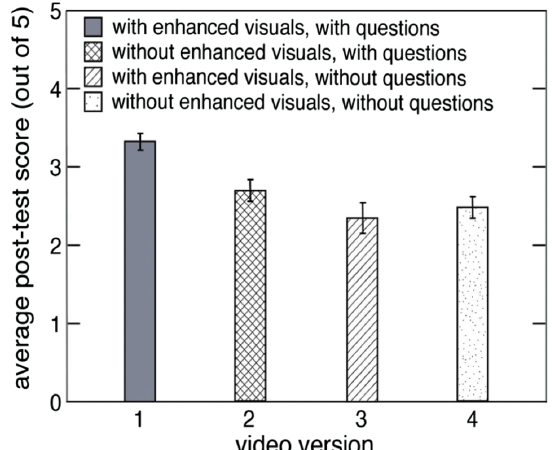
FIG. 9. Average postvideo test score for participants who watched each of the four versions of the videos: version 1: with enhanced visuals and embedded questions; version 2: without enhanced visuals, with embedded questions; version 3: with enhanced visuals, without embedded questions; version 4: with- out enhanced visuals, without embedded questions. Error bars represent the standard error of the